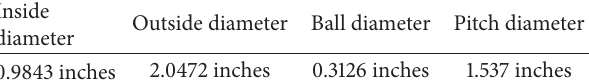
classifier to identify the work condition. The flow chart of the proposed fault diagnosis model is given in Figure 1.